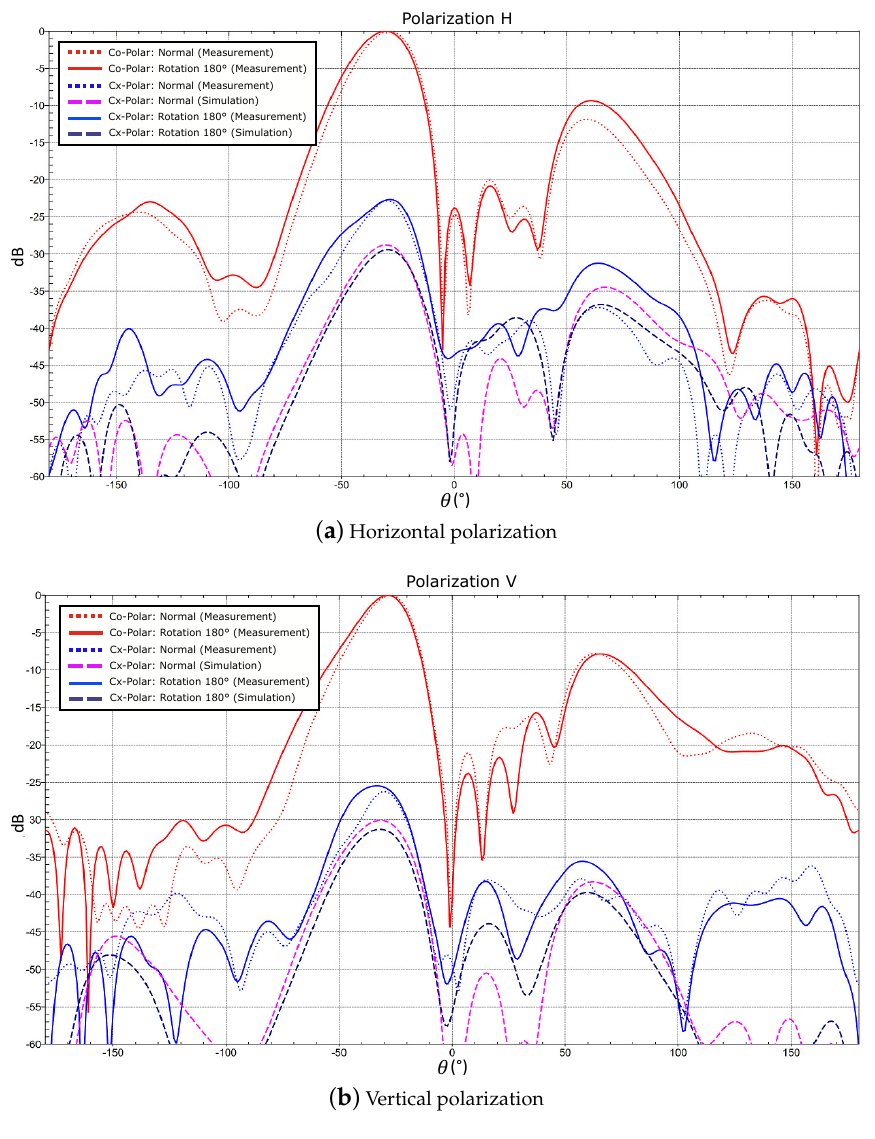
Figure 13. Comparison normal array and array with 180° rotation @ f 0 = 1.325 GHz: normalized co-polar & cross-polar patterns ( ϕ = 90 ◦ ).